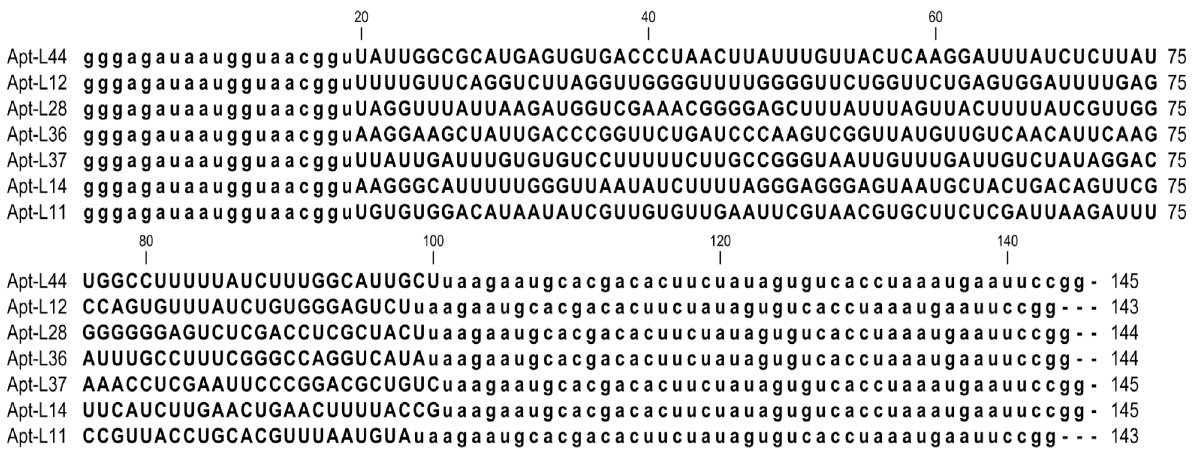
Figure 2. Sequence of TESA binding aptamers. RNA sequence, including the conserved T7 and SP6 primer binding sites (depicted in lower case) for the selected aptamers, Apt-L44, L12, L28, L36, L37, L14 and L11 obtained from round 10 of TESA SELEx, are represented. The nucleotide length of each aptamer is indicated on the right.